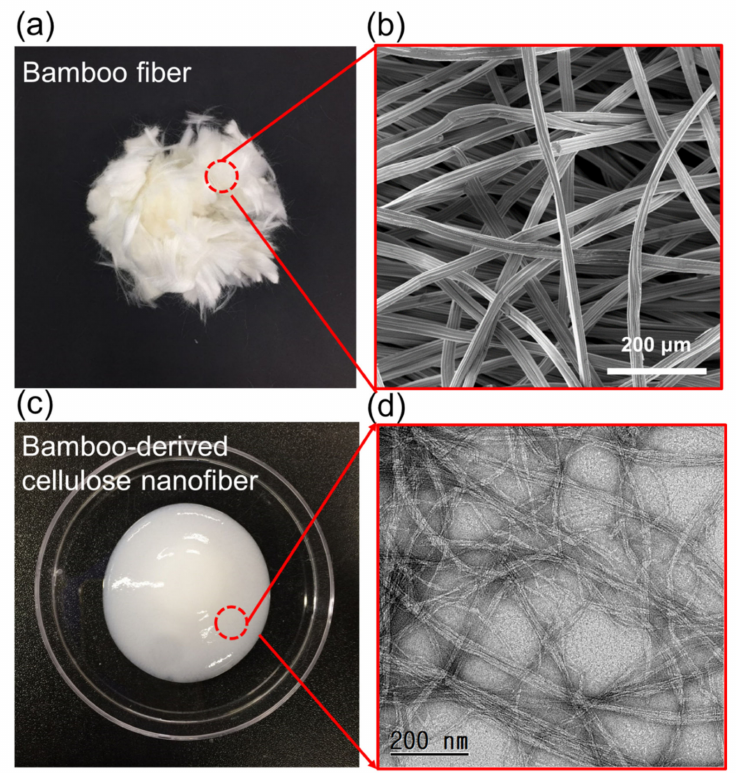
Figure 1. Morphology of bamboo fibers (BFs) and cellulose nanofibrils (CNFs). ( a ) Optical and ( b ) FE-SEM images of BFs. ( c ) Optical and ( d ) FE-TEM images of